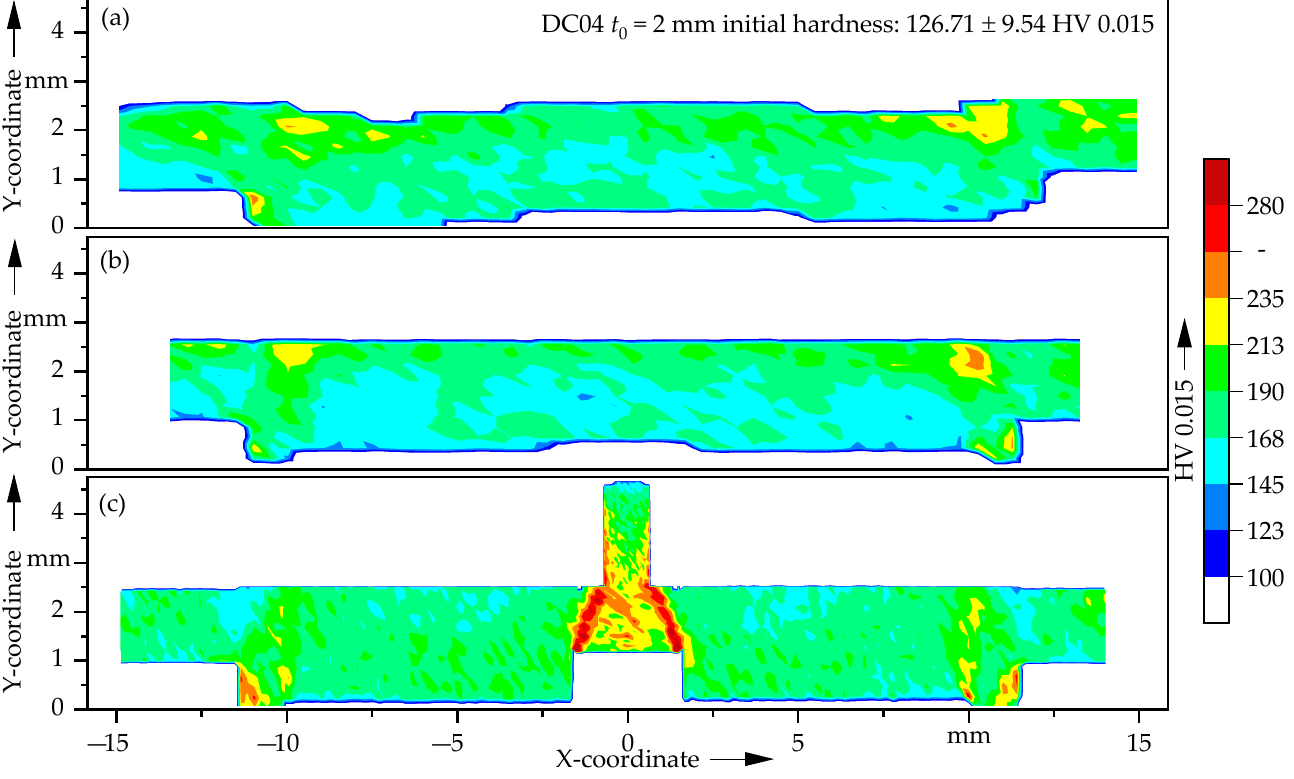
Figure 6. Hardness distribution of the process sequence for the pin extrusion with orbital formed tailored blanks with local material pre-distribution. ( a ) First step—orbital forming ( b ) second step— calibrated specimen ( c ) third step—calibrated specimen with extruded pin structure.